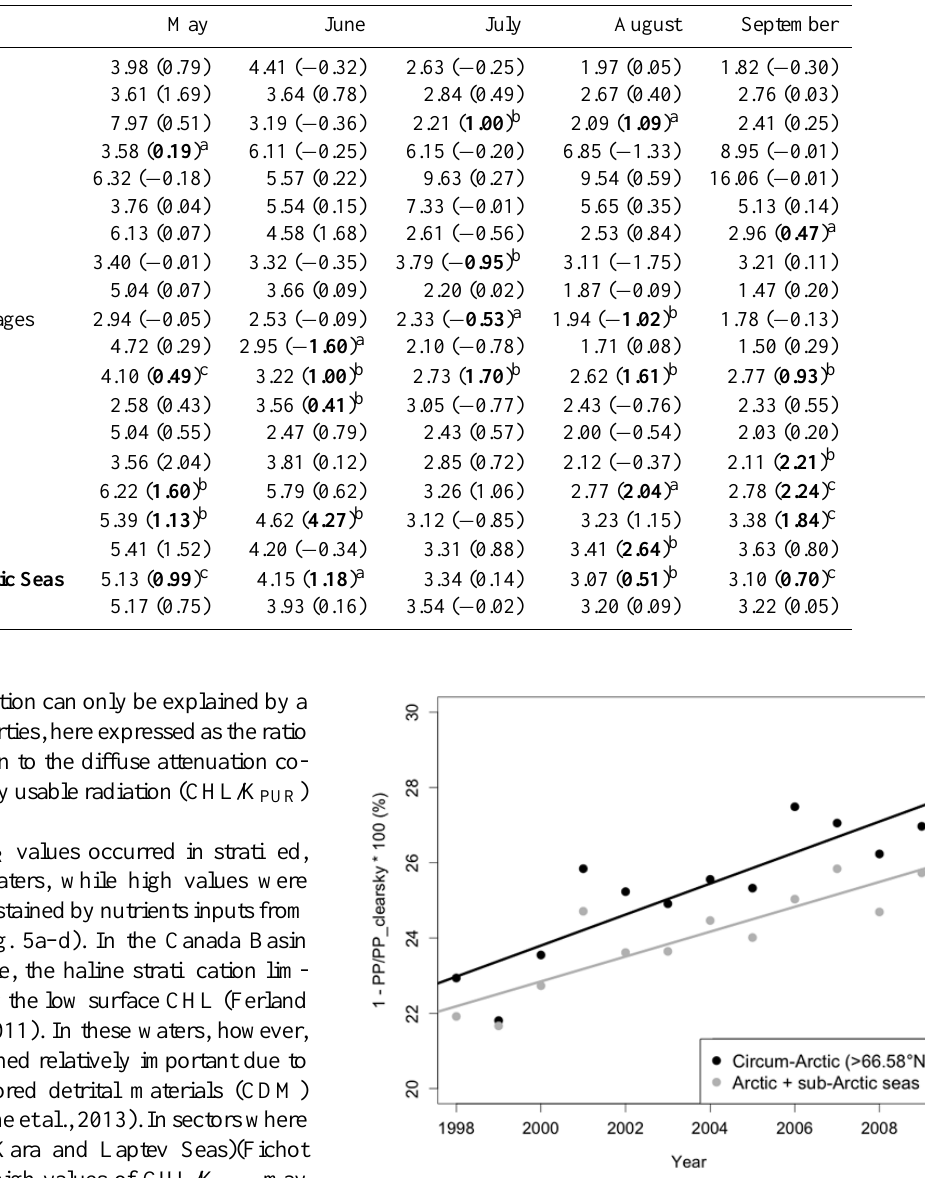
Table 4. Regionally averaged CHL/K PUR (in mg CHL m − 2 ) and its relative trends computed for the 1998 to 2010 period (in parenthesis, in %yr − 1 ). Significant trends are in bold text with superscript indicating the level of significance: (a) 0 . 05 < p < 0 . 1, (b) 0 . 01 < p < 0 . 05, and (c) p < 0 . 01